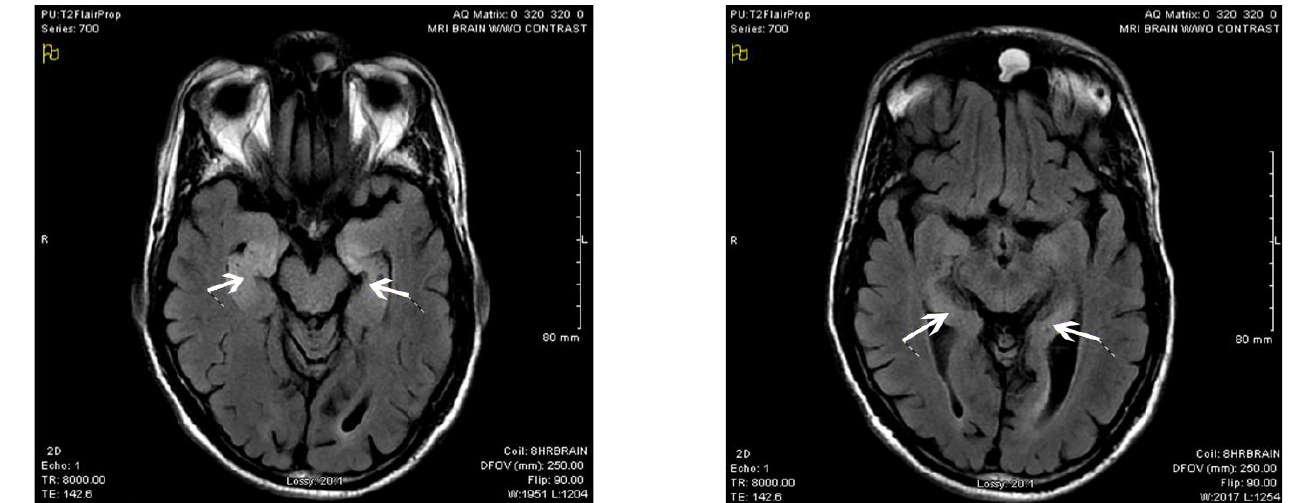
Image 1. Axial T2 FLAIR sequence magnetic resonance imaging showing bilateral enhancement of the hippocampus (arrows). FLAIR, fluid attenuated inversion recovery